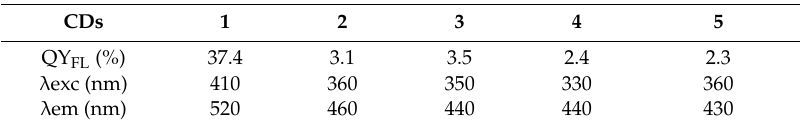
Figure 1. Absorption spectra of the five CDs. Data were normalized. Table 2. Fluorescence quantum yield (QY FL , in %), excitation maximum ( λ exc, in nm) and emission maximum wavelengths ( λ em, in nm) for the five studied CDs.